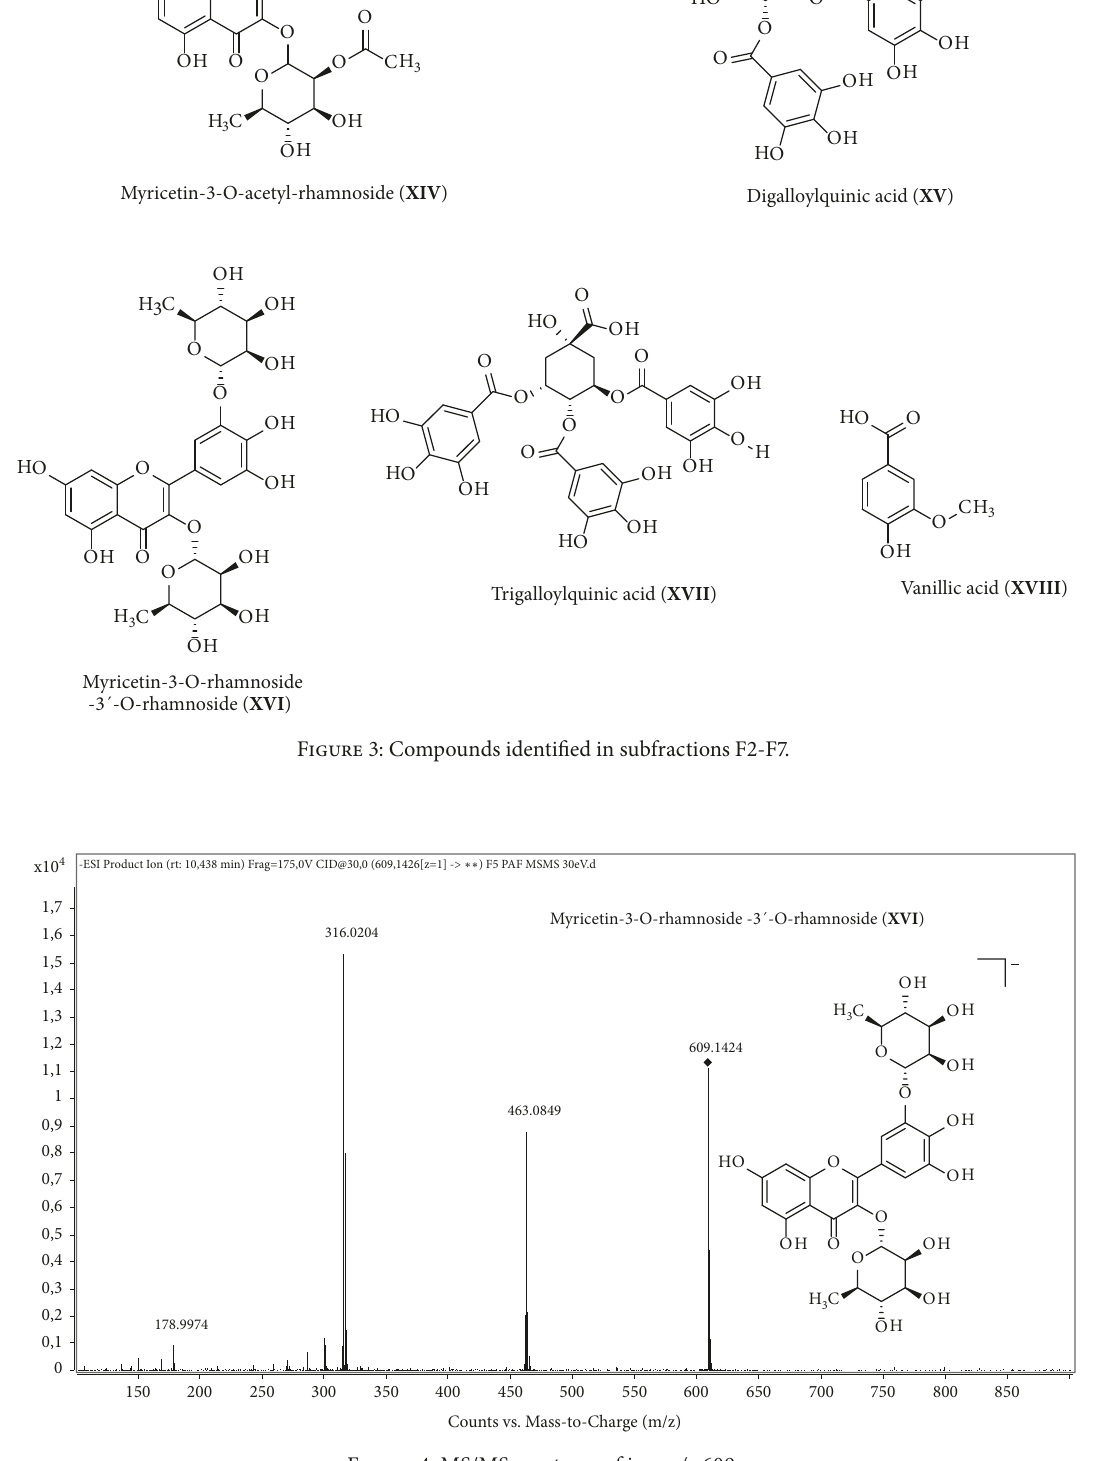
Figure 4: MS/MS spectrum of ion m/z